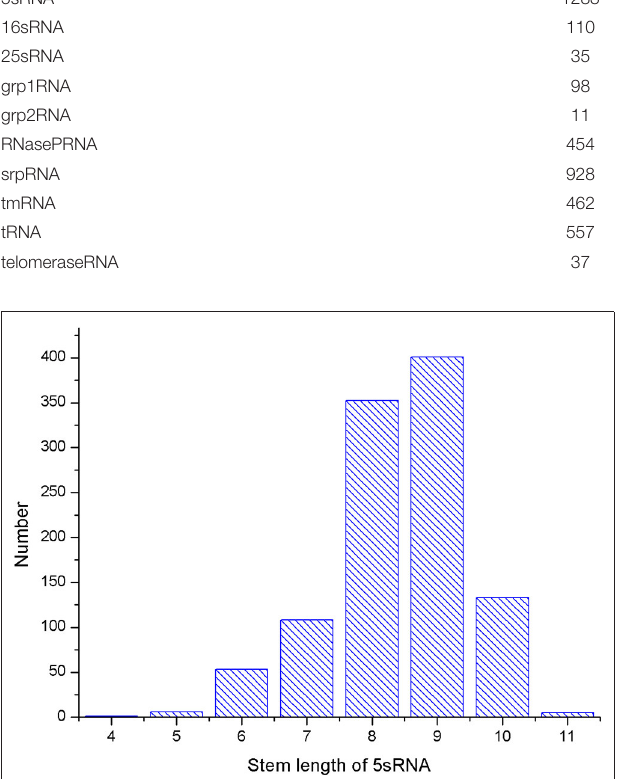
FIGURE 3 | 5sRNA maximum stem length statistics.